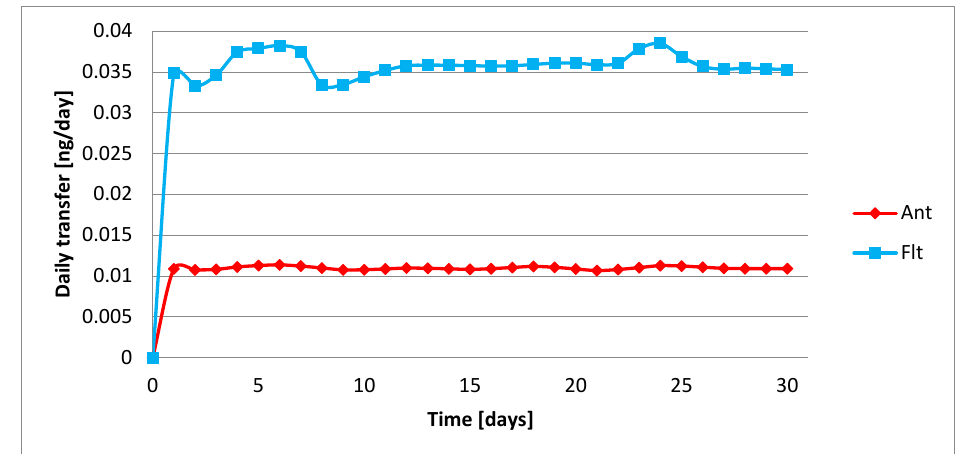
Figure 10. Transfer of contaminant from kidneys to urine (subject 1). Lead (Pb).